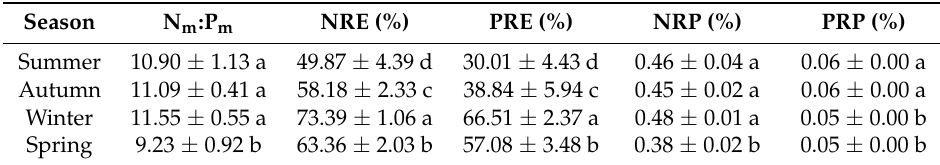
Table 1. Seasonal changes in the nitrogen and phosphorus ratios (N:P), nitrogen resorption efficiency (NRE), phosphorus resorption efficiency (PRE), nitrogen resorption proficiency (NRP), and phosphorus resorption proficiency (PRP) of A. corniculatum